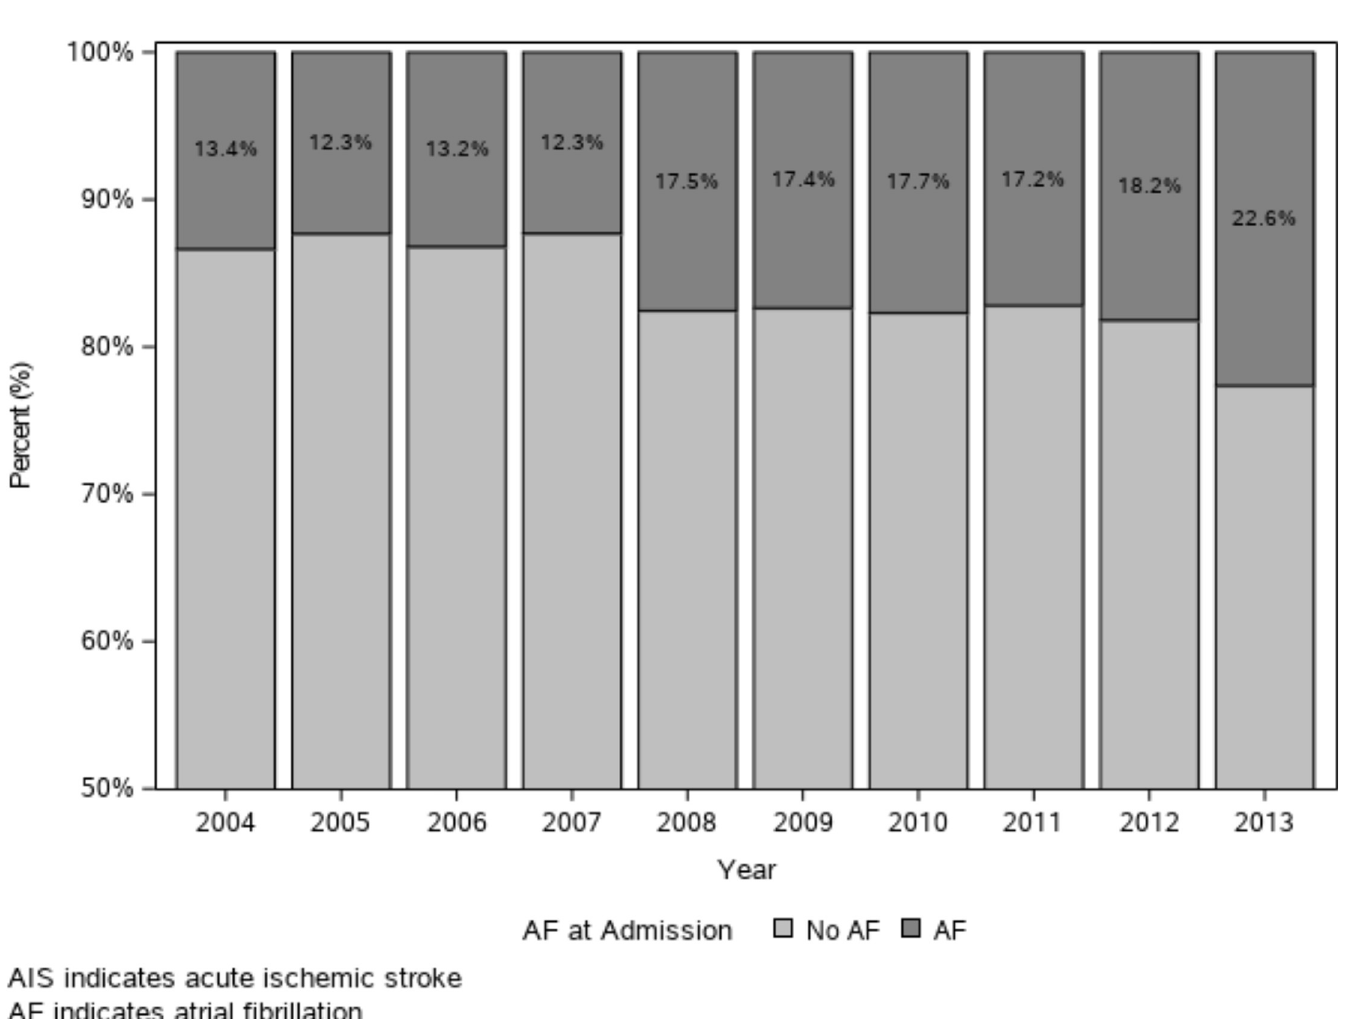
Fig 2. Proportion of acute ischemic stroke with atrial fibrillation from 2004 to